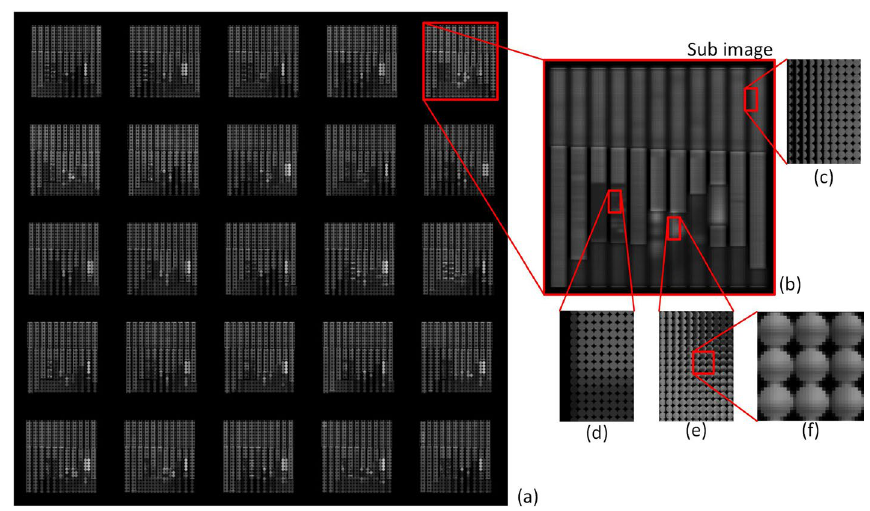
Fig. 6 The simulation raw data collected by the detector of the SDSIIL, a is the entire raw data, b is one of the sub images, c is the enlarged view of the 2 mm depth region, d is the enlarged view of the 0 mm depth − region, e is the enlarged view of the 2 mm depth region, f is the enlarged view of sub pupil image behind some microlens